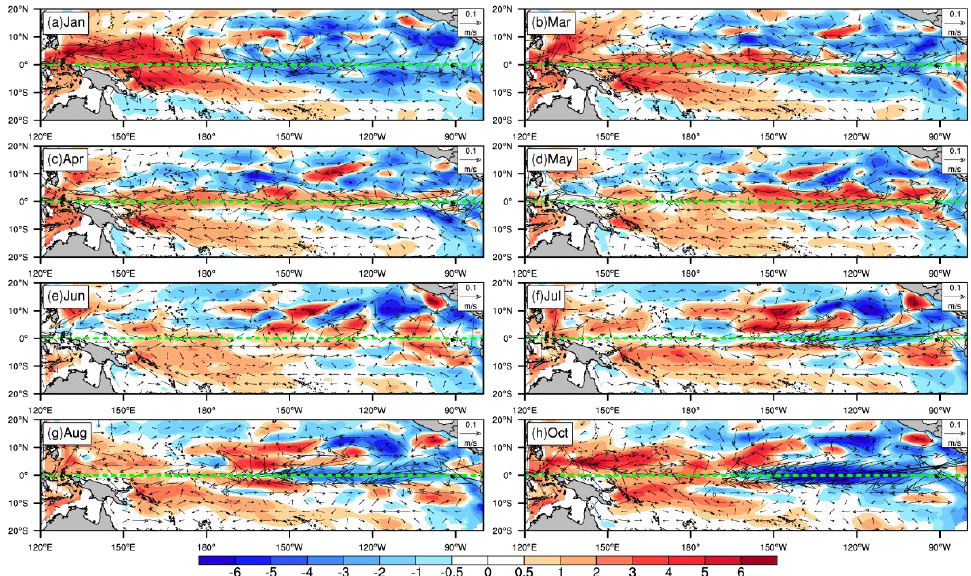
Figure 5. The spatial distribution of the temperature (shading) and ocean current (vectors) anomalies evaluated at the thermocline depth in January, March, April, May, June, July, August, and October 2021. Units: °C for temperature; m s − 1 for currents.